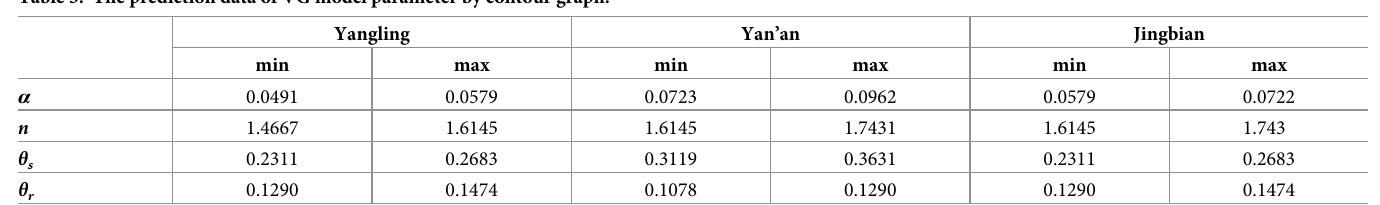
Table 5. The prediction data of VG model parameter by contour